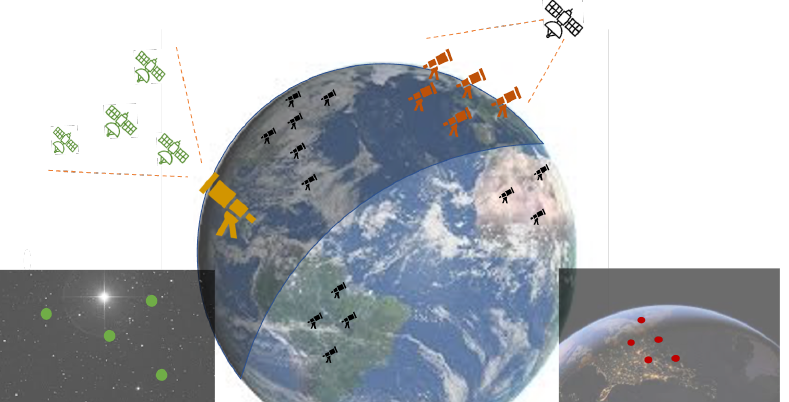
Figure 1. A general illustration of the satellite–terrestrial FSO communication resource allocation and scheduling model. On the ( left side), a ground station’s point of view is presented: the orange telescope should be aligned to one of the four (green) nano-satellites. On the ( right side), a nano- satellite’s point of view is shown: it should point to one of the five (red) ground stations.